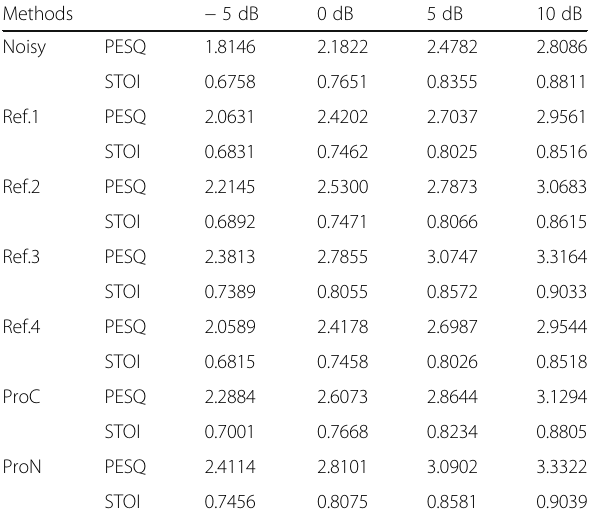
Table 5 Comparison on average STOI and PESQ